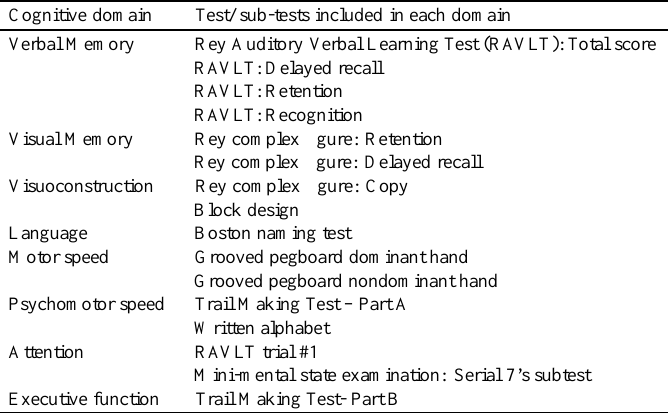
Table 1 Cognitive tests performed within each of 8 cognitive domains